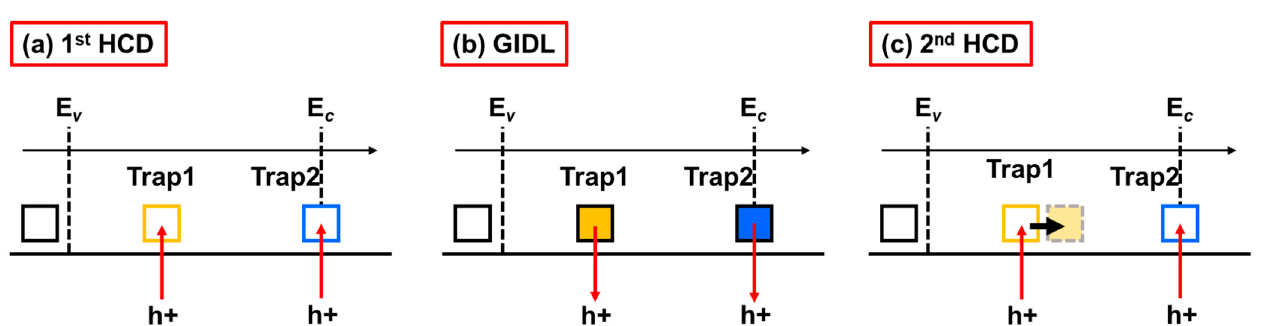
Figure 12. Energy level diagrams during ( a ) the first round of HCD stress, ( b ) GIDL repairing process, and ( c ) the second round of HCD stress. Table 2. List of abbreviations and notations frequently used in this